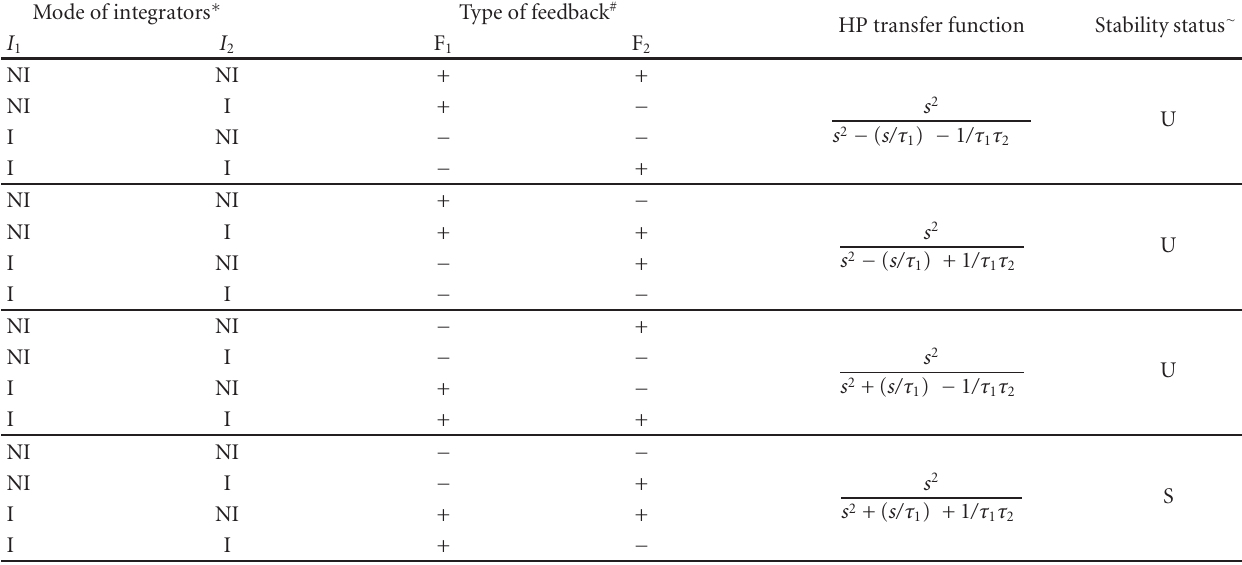
Table 2: Table demonstrating that the four MFF configurations presented in the paper are the only stable ones. Mode of integrators ∗